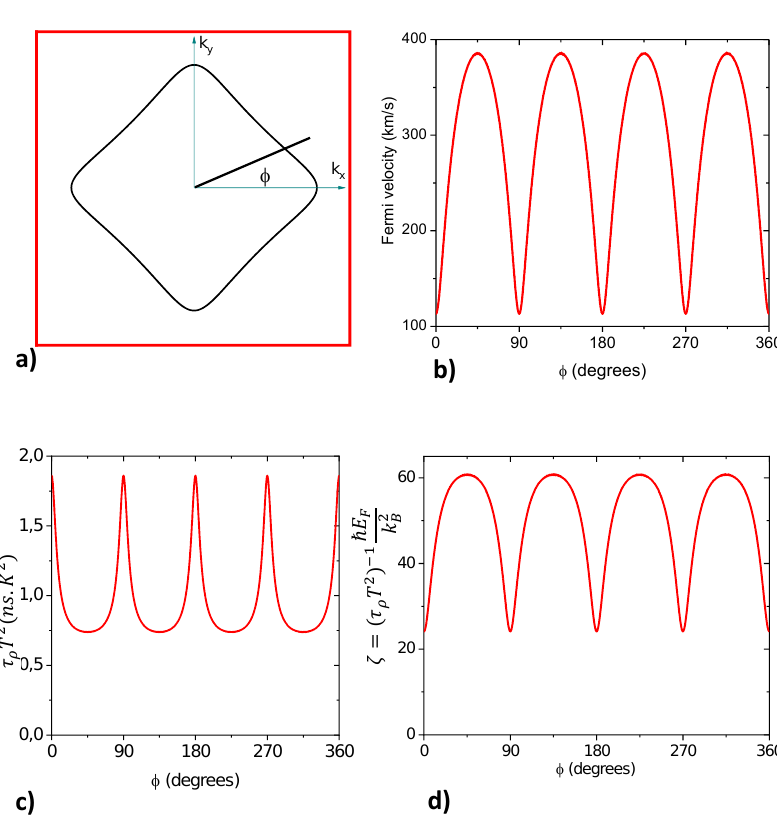
Figure 5: Angular variation of collision time in heavily overdoped LSCO: a) Fermi surface and the Brillouin zone of La velocity; c) Angular variation of the scattering time derived from resistivity times T 2 ; d) Angular dependence of dimensionless ζ extracted from τ ρ T 2 and